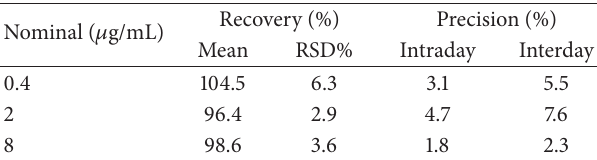
Table 1: Recovery and intra- and interday precision of LC-MS method ( 𝑛 =